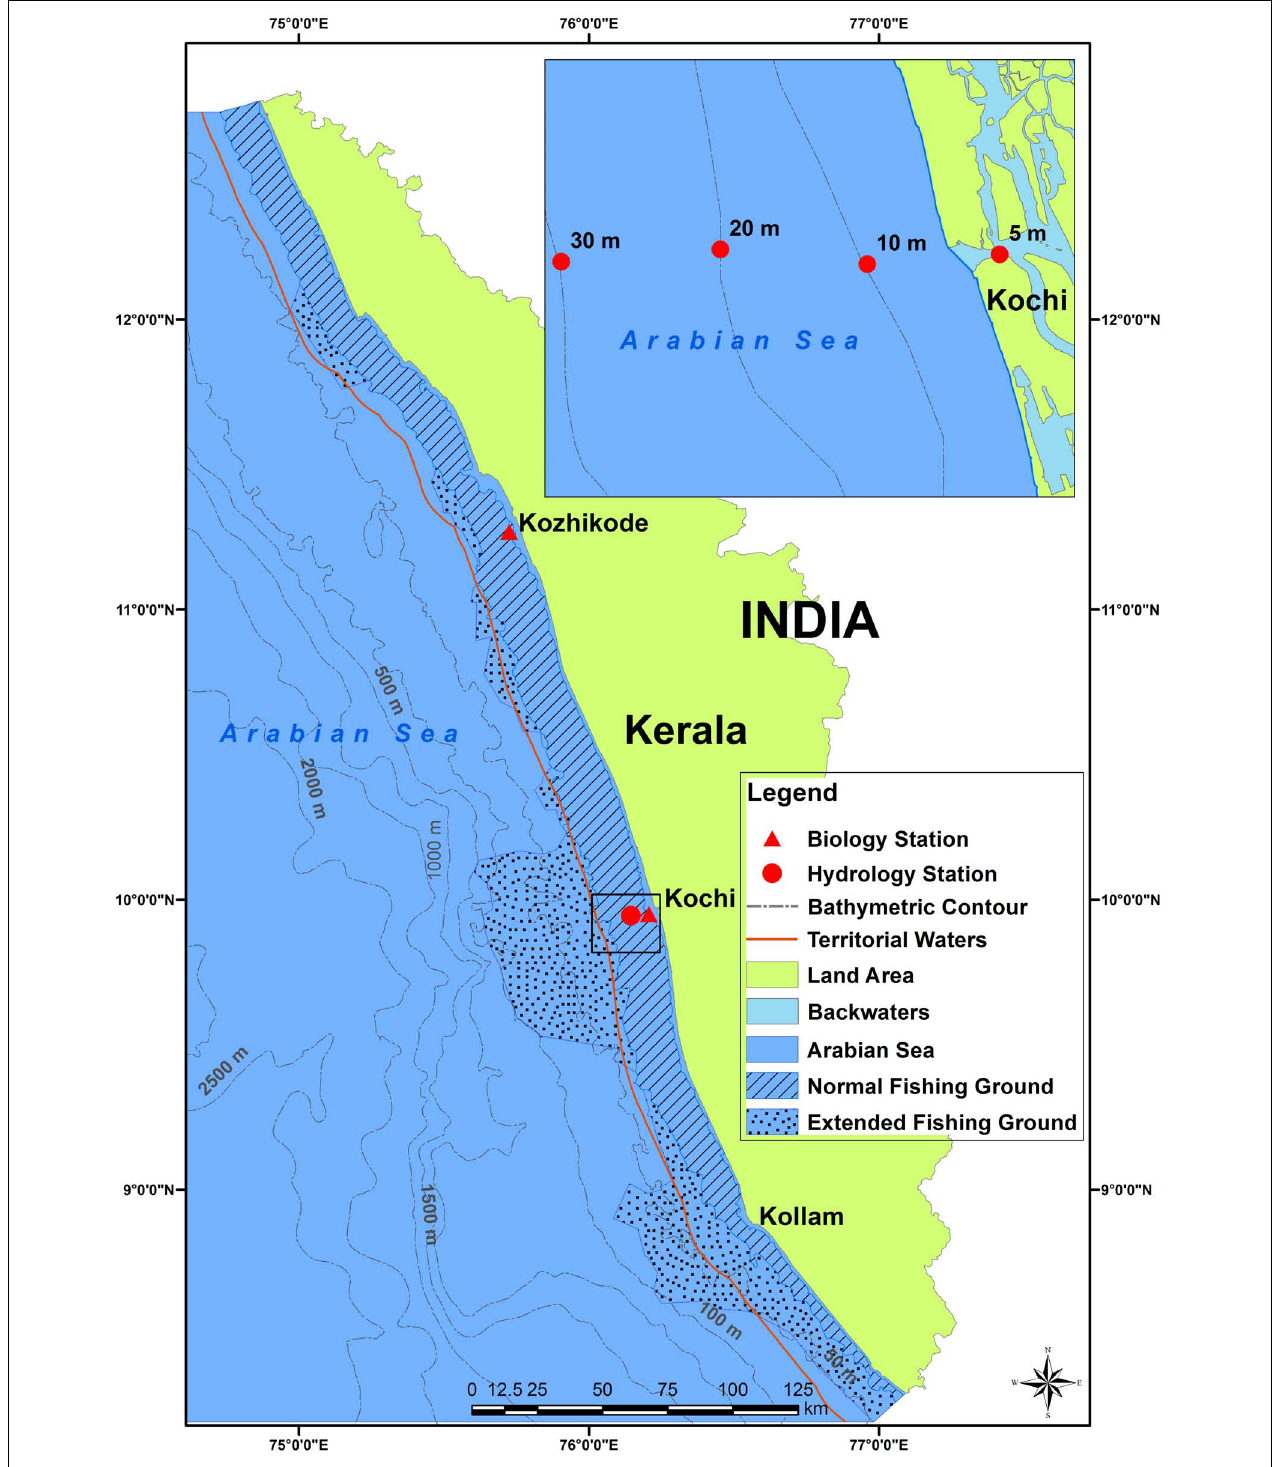
FIGURE 1 | Map showing southeastern Arabian Sea off Kerala State with bathymetric contours. The hydrology and biology sampling stations are indicated. Inset shows detail of hydrology sampling stations. Shaded areas indicate the traditional oil sardine fishing grounds and the stippled area indicates the extended fishing